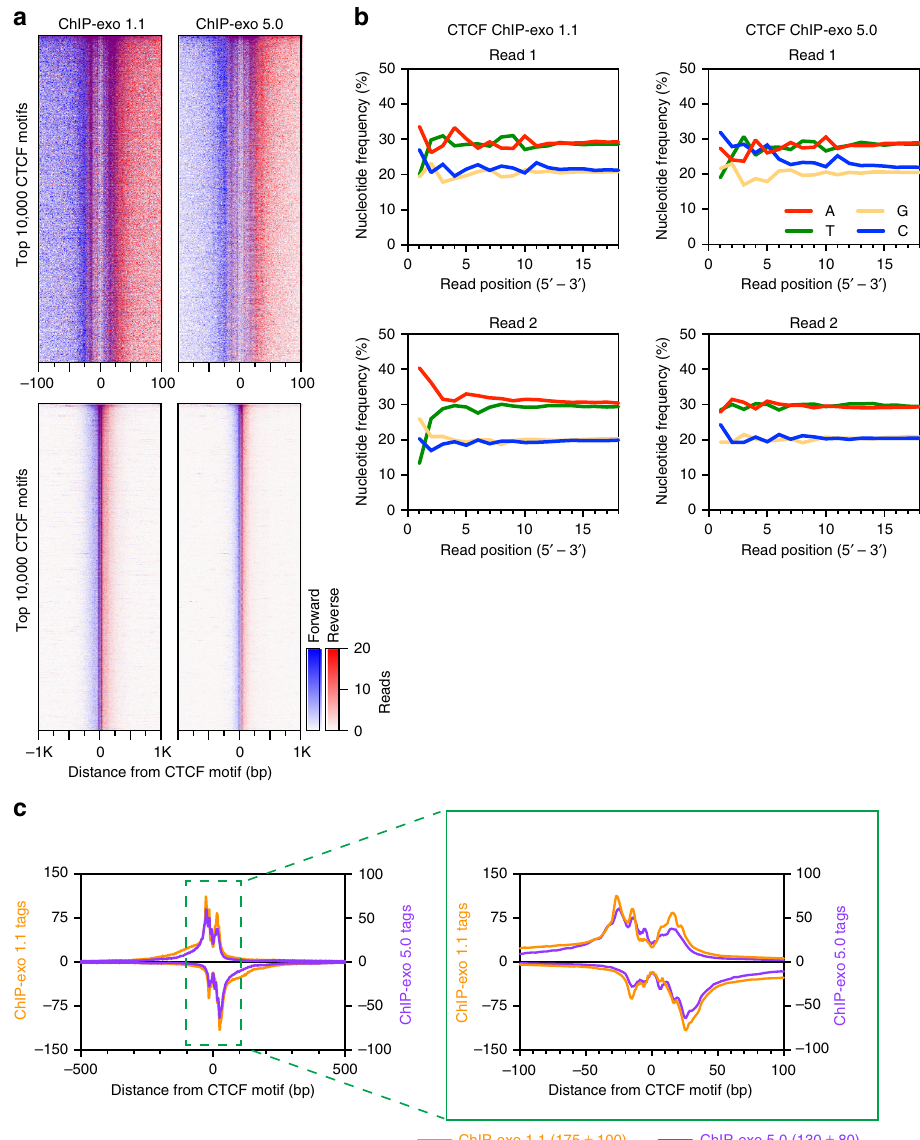
Fig. 5 ChIP-exo 5.0 produced the same quality data as ChIP-exo 1.1. a Heatmaps comparing ChIP-exo 1.1 and ChIP-exo 5.0 at the top 10,000 H. sapiens CTCF motifs in a 200 bp (top) or 2 kb (bottom) window. b Comparison of the nucleotide frequency at the 5 ′ end of the sequencing tags for ChIP-exo 1.1 and ChIP-exo 5.0 in CTCF datasets. Read_1 5 ′ end is the product of exonuclease digestion. Read_2 5 ′ end is the product of ligation following A-tailing of sonicated ends. c Composite plots of data in panel ( a ) in a 1 kb window (left) and zoomed to 200 bp (right) NATURE COMMUNICATIONS| (2018) 9:2842 |DOI: